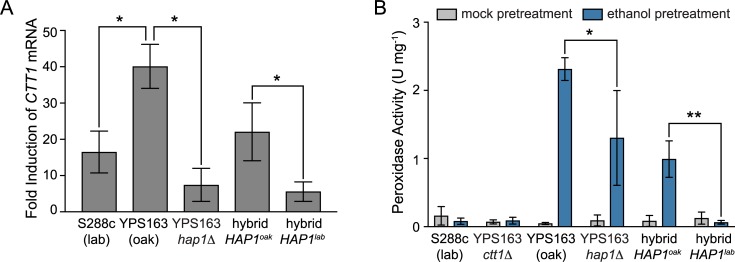
HAP1 is required for full induction of CTT1 gene expression and cellular peroxidase activity during ethanol stress.(A) Fold induction of CTT1 mRNA in indicated strains following 30 min ethanol stress compared to unstressed cells, assessed by qPCR. (B) Peroxidase activity measured in cell-free extracts in either mock-treated or ethanol-stressed cells. The plots indicate the mean and standard deviation of biological triplicates (mRNA) or quadruplicates (peroxidase activity). Asterisks represent significant differences in CTT1 mRNA induction or peroxidase activity between denoted strains (* P < 0.05, ** P < 0.01, paired t-test).